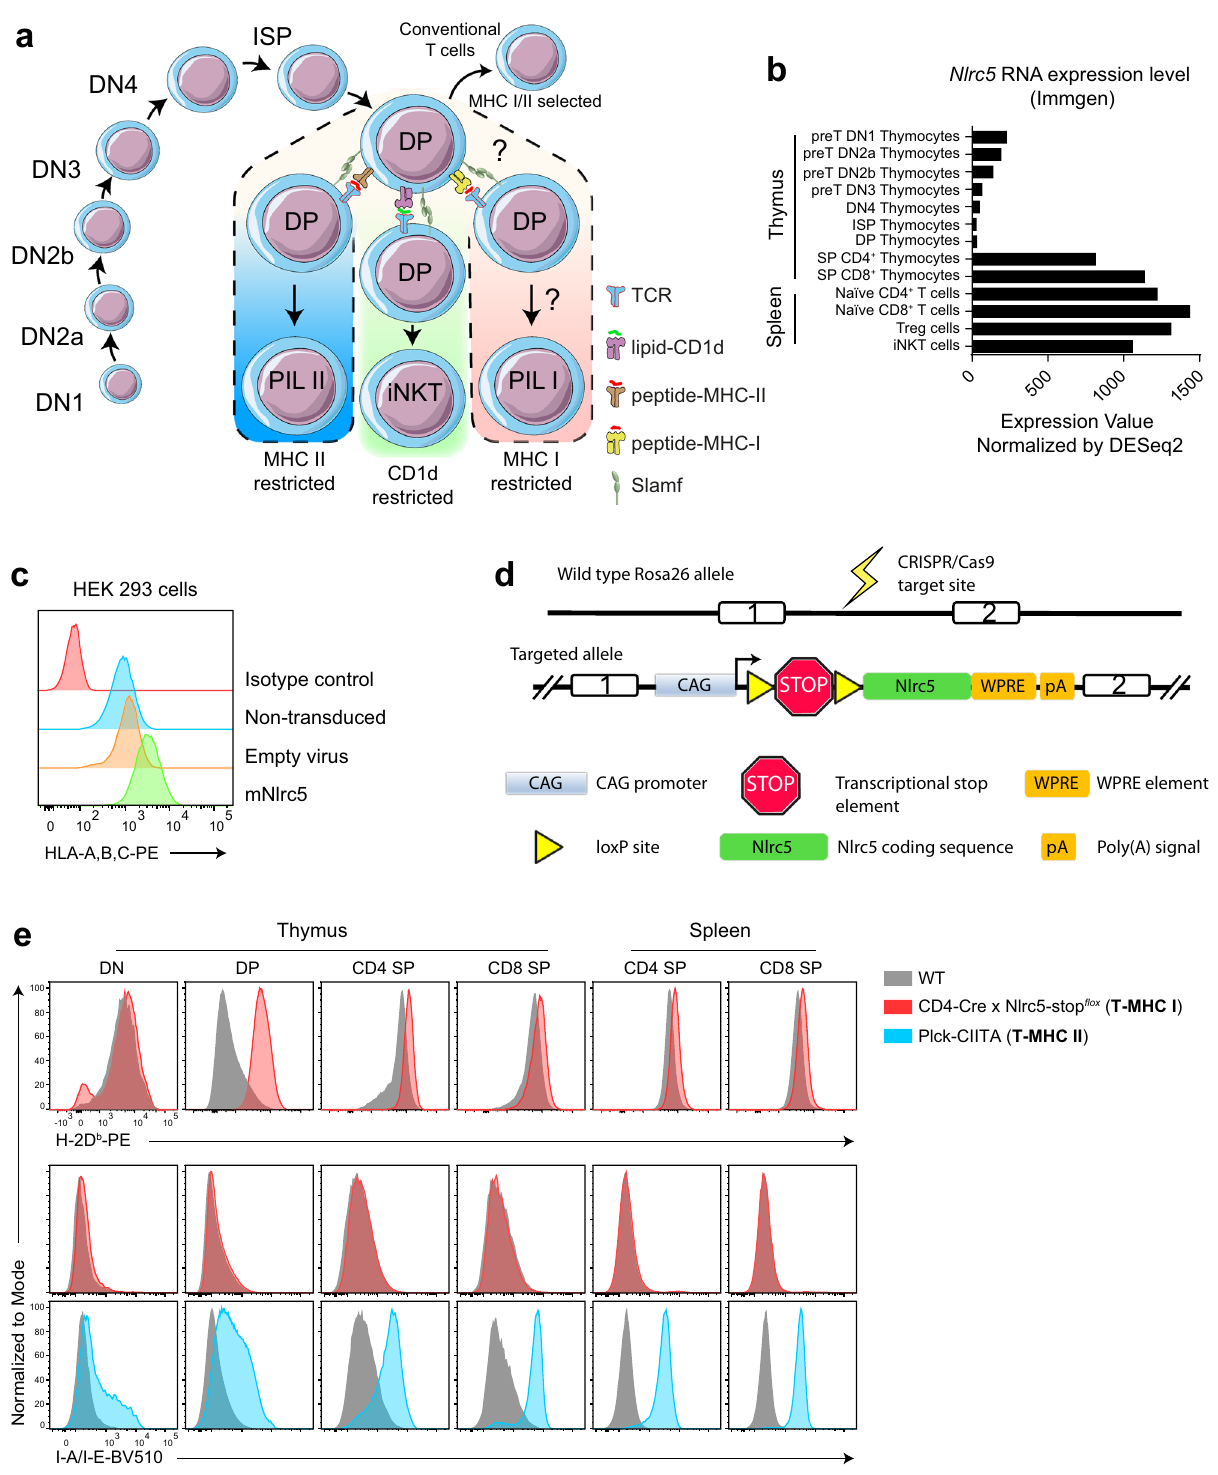
Fig. 1 An inducible Nlrc5 (CITA) approach to force DP thymocytes to express MHC Class I molecules. a Schematic representation of positive selection of innate-like T cells on DP thymocytes. b mRNA expression level of murine Nlrc5 in different T-cell subsets from B6 WT mice. Data were obtained from ImmGen. c Flow cytometry analysis of HEK 293 cells transduced with lentivirus expression vector encoding the murine Nlrc5 coding sequence (CDS) or with empty virus as a control. As additional controls, non-transduced cells and isotype control staining are shown. Cells are analyzed 48 h post transduction. d Structure of the wild-type (WT) Rosa26 and the targeted allele of the transgenic mouse (Nlrc5-stop fl ox ). e Flow cytometry evaluation of MHC I and MHC II expression on T cells from WT, CD4-Cre× Nlrc5-stop fl ox (T-MHC I), and Plck-CIITA (T-MHC II) transgenic mice. Data are representative of fi ve independent experiments, n ≥ 5 mice per experimental group. Source data are provided as a Source Data fi